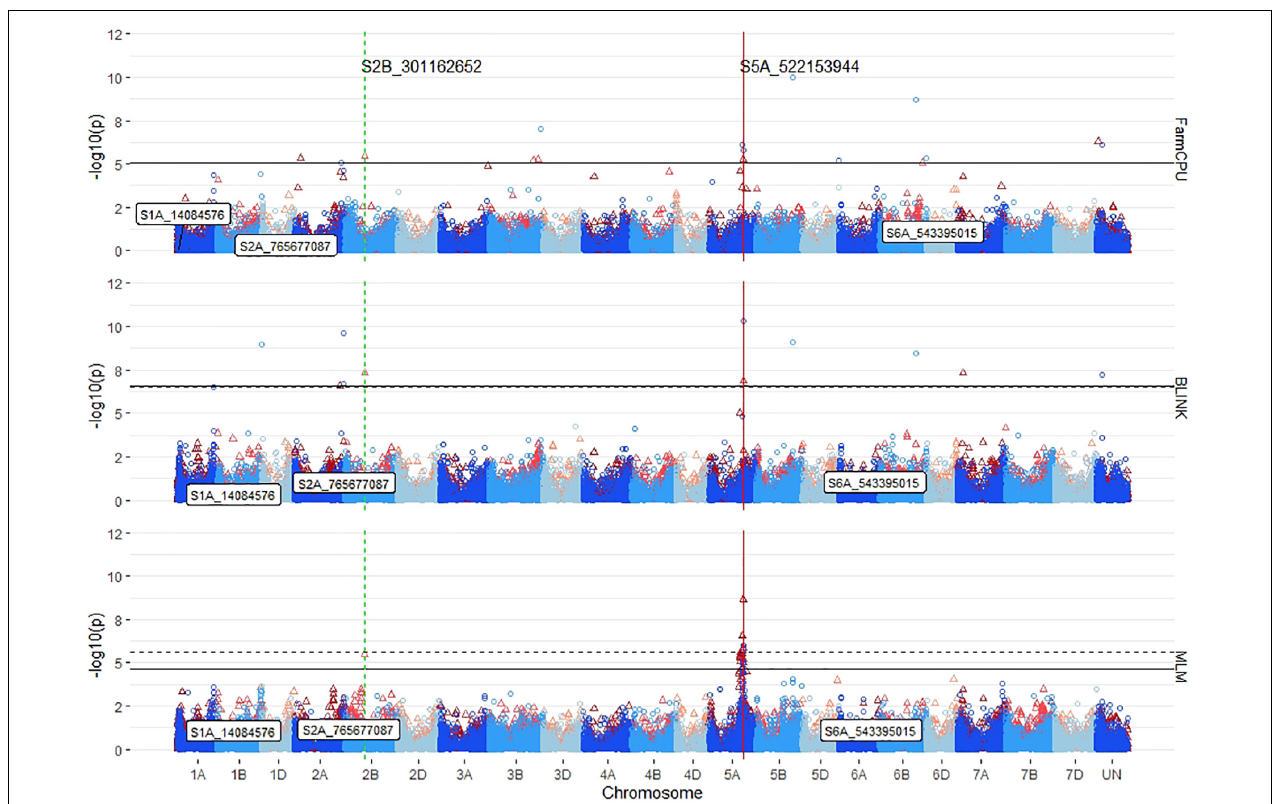
FIGURE 6 | Stacked Manhattan plots for GWASs using MLM, FarmCPU, and BLINK for identifying significant loci controlling deep-sowing seedling emergence in a Pacific Northwest winter wheat diversity panel (DP) phenotyped across trials from 2015 to 2018 and a BL trial phenotyped in 2015 in Lind, WA. Red triangles display GWAS results in the DP, and blue circles identify GWAS results in the BL. Significant markers using a false discovery rate (FDR) cut-off with an alpha = 0.05 are placed above the solid black line for the DP and the dashed black line for the BL. Significant markers across both populations are identified with a vertical red solid line identifying their positions. Markers enclosed in a white text box display significant markers identified in GWASs for coleoptile